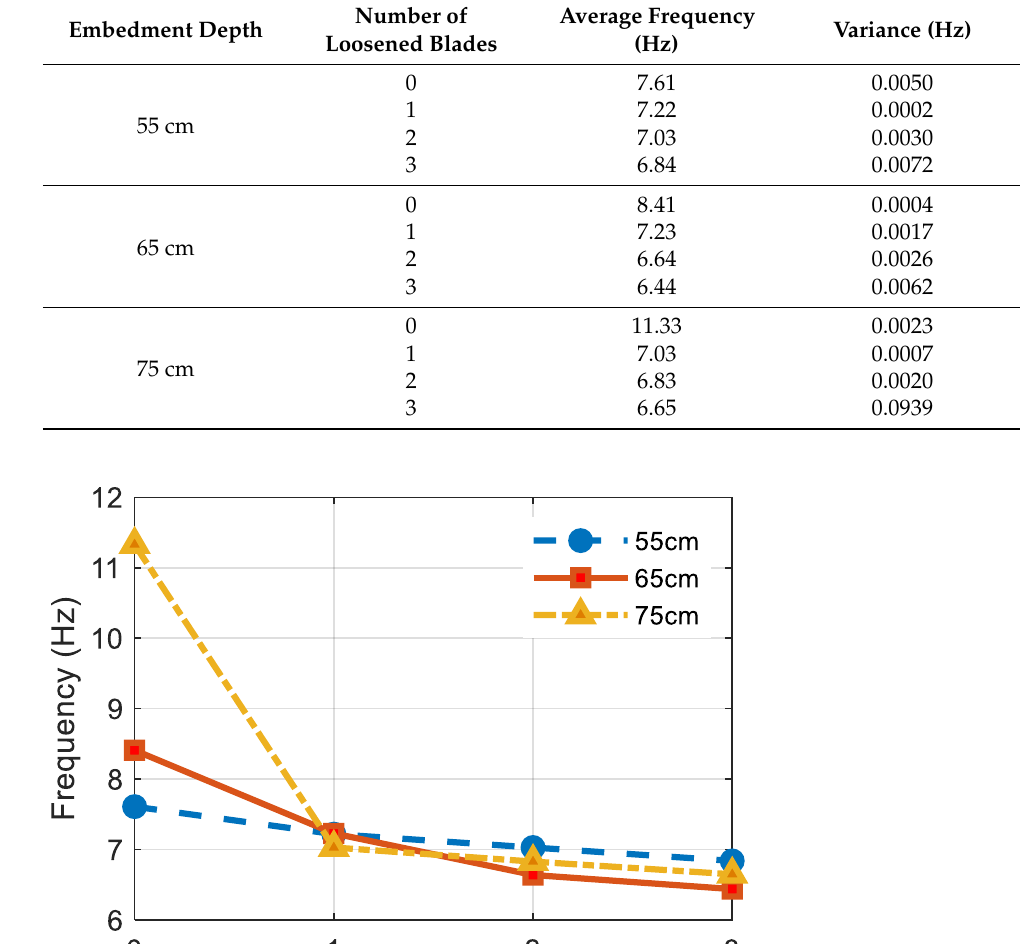
Table 3. Frequency of the OWT with loosened blades.